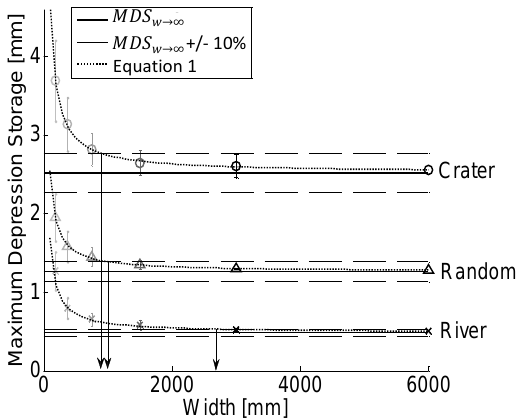
Figure 9: Synthetic Fields – Effect of plot width on the maximum depression storage for the 2 Fig. 9. Synthetic fields – effect of plot width on the maximum de- “River”, “Random” and “Crater” type microtopographies. Vertical bars = standard 3 pression storage for the river, random and crater type microtopogra- phies. Vertical bars=standard deviations. The arrows indicate the deviations. The arrows indicate the ‘representative width’. All the plots are 6 m long. 4 representative width. All the plots are 6m long.